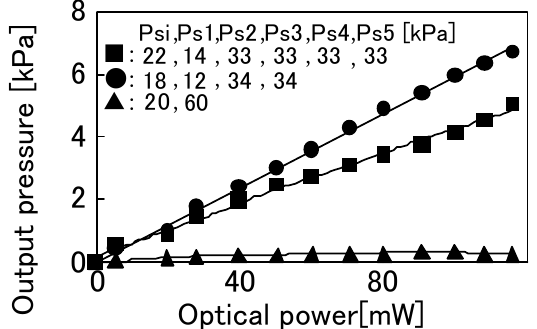
Fig. 2 Static characteristics of the interface